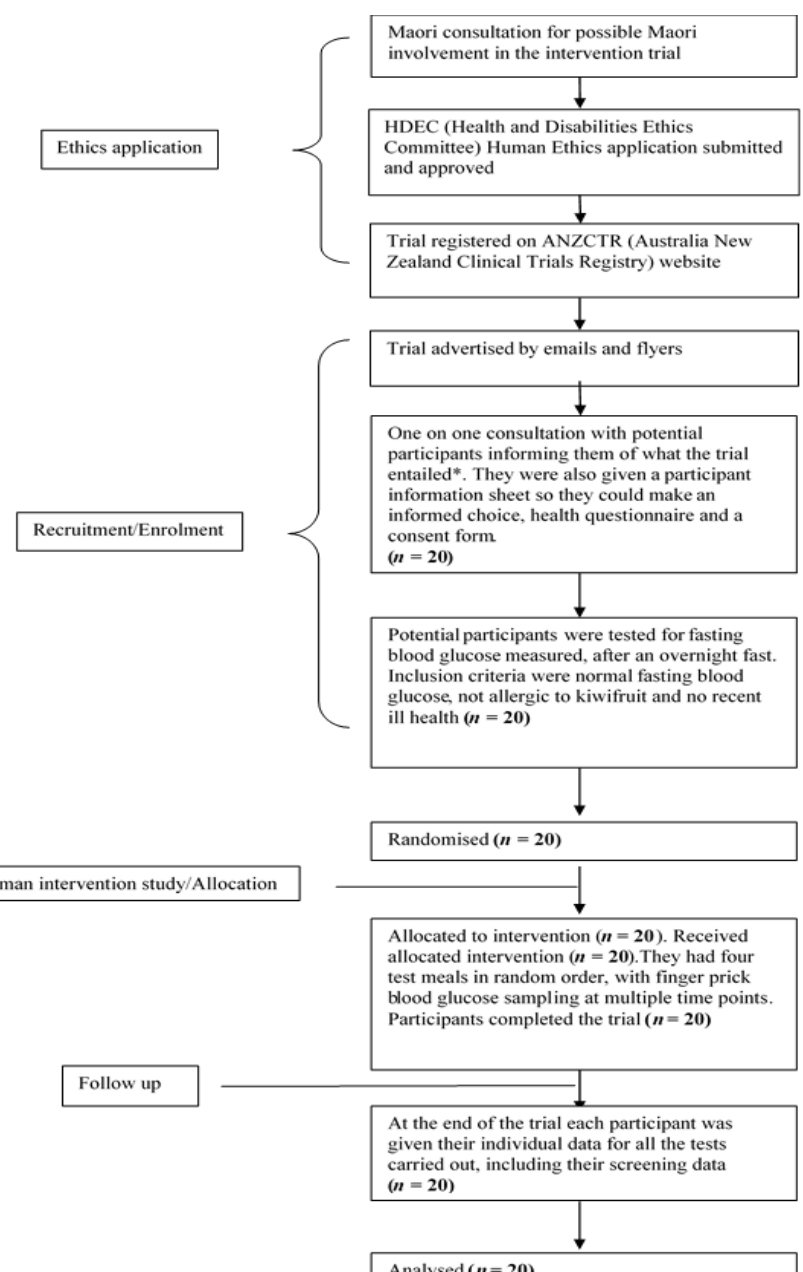
Figure 1. Participant flow chart shows ethical approval, recruitment and intervention processes for the trial . * The participants were allowed to bring a family member of their “Whanau” (support person, family or friend) as family support is highly valued in Maori